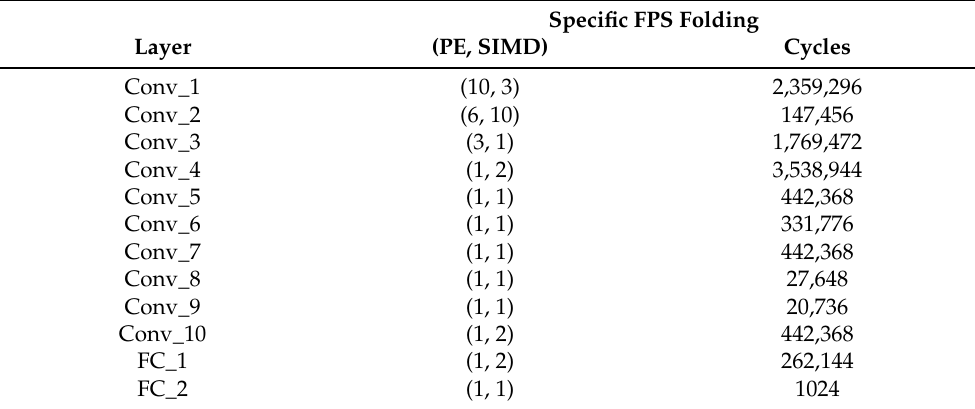
Table 8. Parallelization settings and their respective estimated number of clock cycles for targeting specific 10